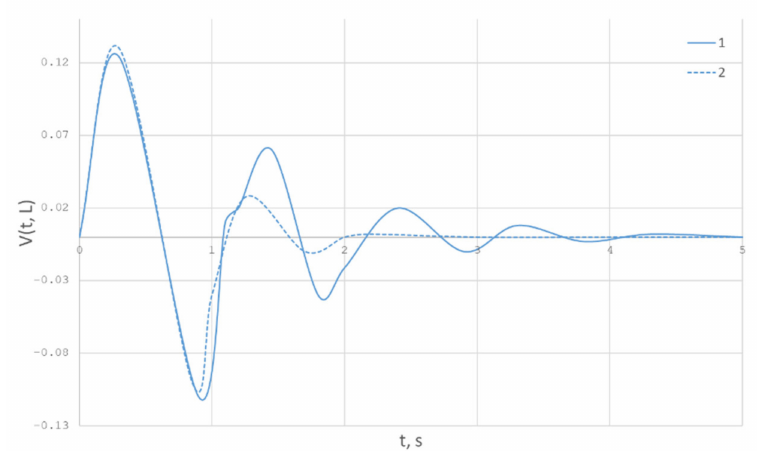
Figure 20. Comparison of the deviation functions of the resulted fiber radii for two drawing modes: (cid:101) u = 0 (line 1); the optimal value of the control function (line